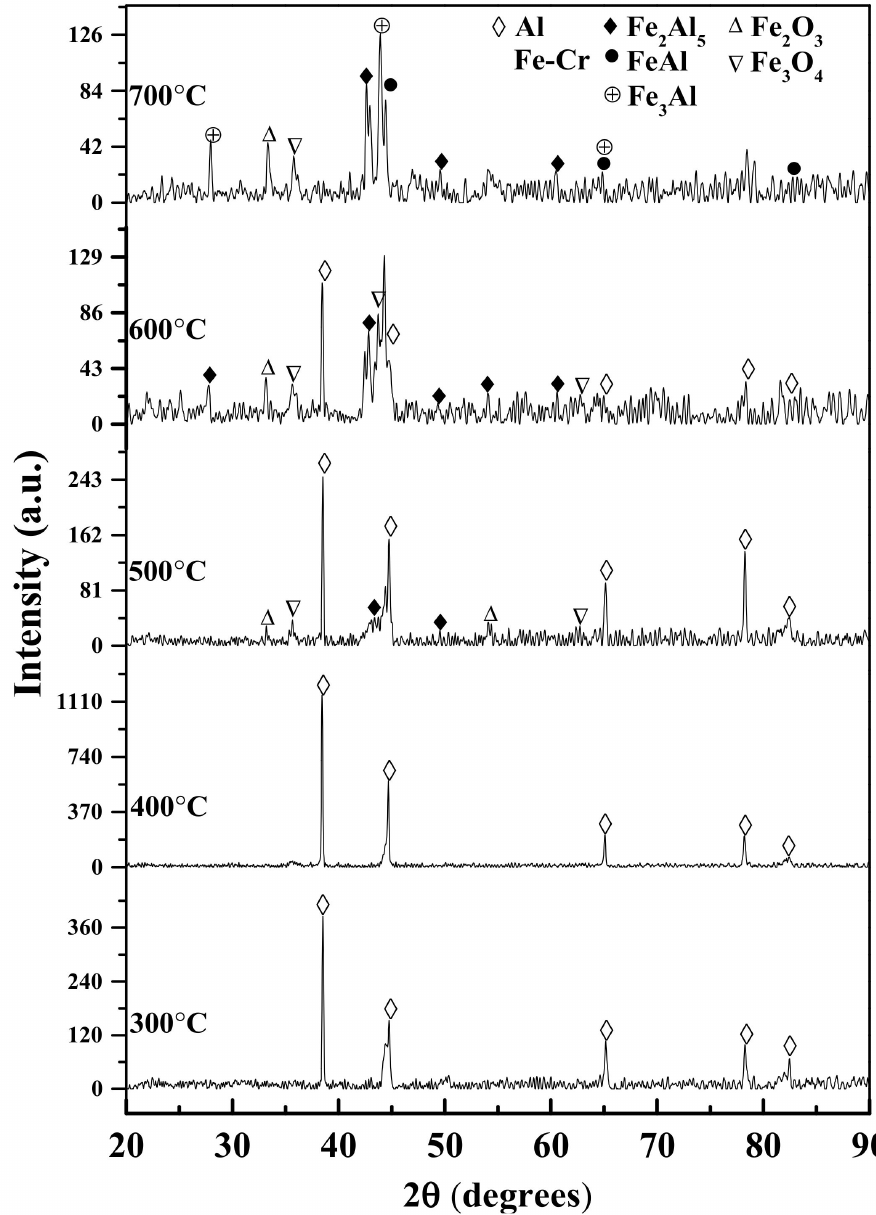
Figure 6. XRD patterns of the coatings at different